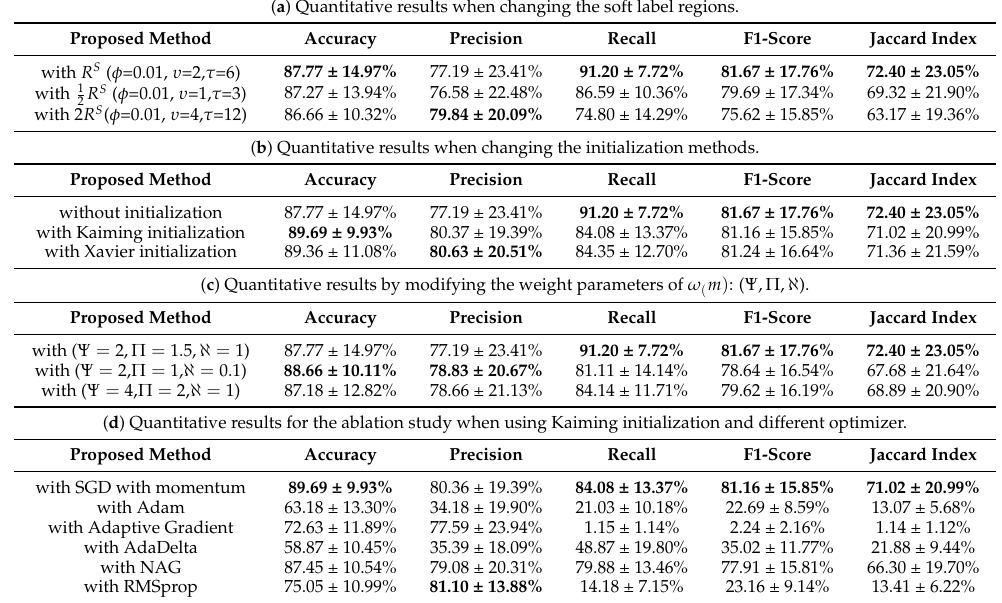
Table 8. Quantitative results for the ablation